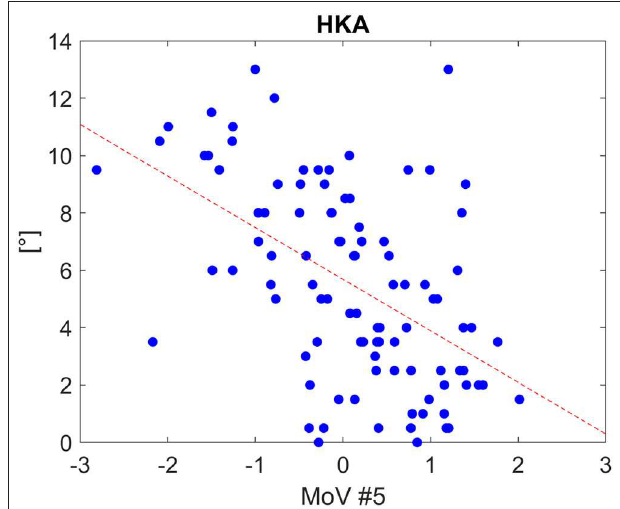
FIGURE 5 | Scatter plot for HKA distribution as a function of MoV #5 range, along with the linear fitting (Spearman correlation coefficients: − 0.52 with p < 1e-07). The tendency line is depicted (red dashed